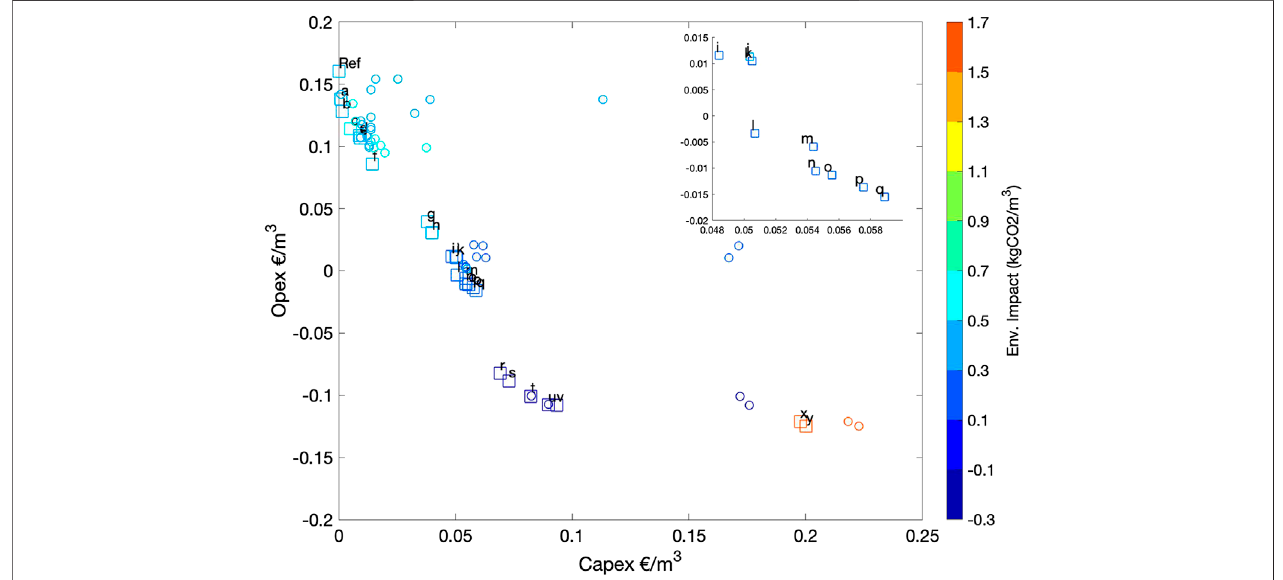
FIGURE 4 | Solution set (circles and squares); Pareto points are the ones represented by squares and contain the same reference as in Table 7 . Color shows the interval gap of environmental impact. Subplot is a zoom for points between i and q .